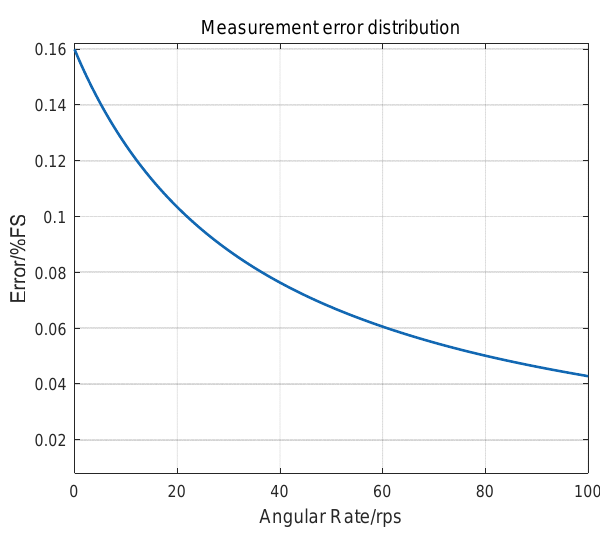
Figure 11. Sensor measurement error vs. rate.